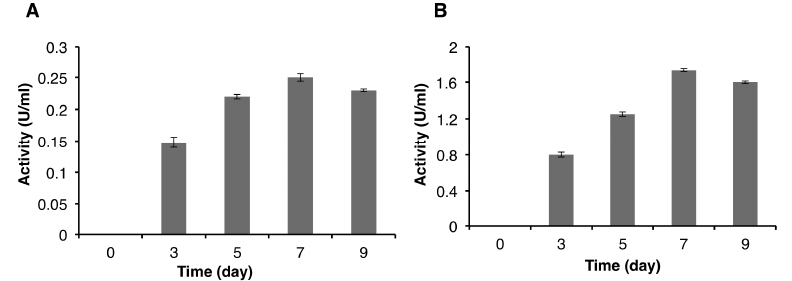
Figure 4. FPase ( A ) and carboxymethyl cellulose (CMC)ase ( B ) activities produced by P. occitanis Pol6 taken at the 3rd, 5th, 7th, and 9th day of culture.